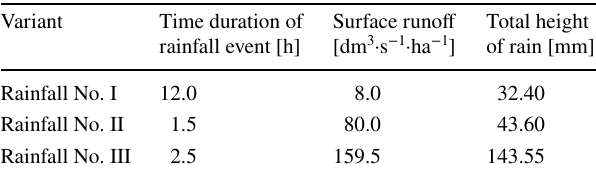
Table 3 Area of particular types of surface sealing for both modeling variants, A and B,